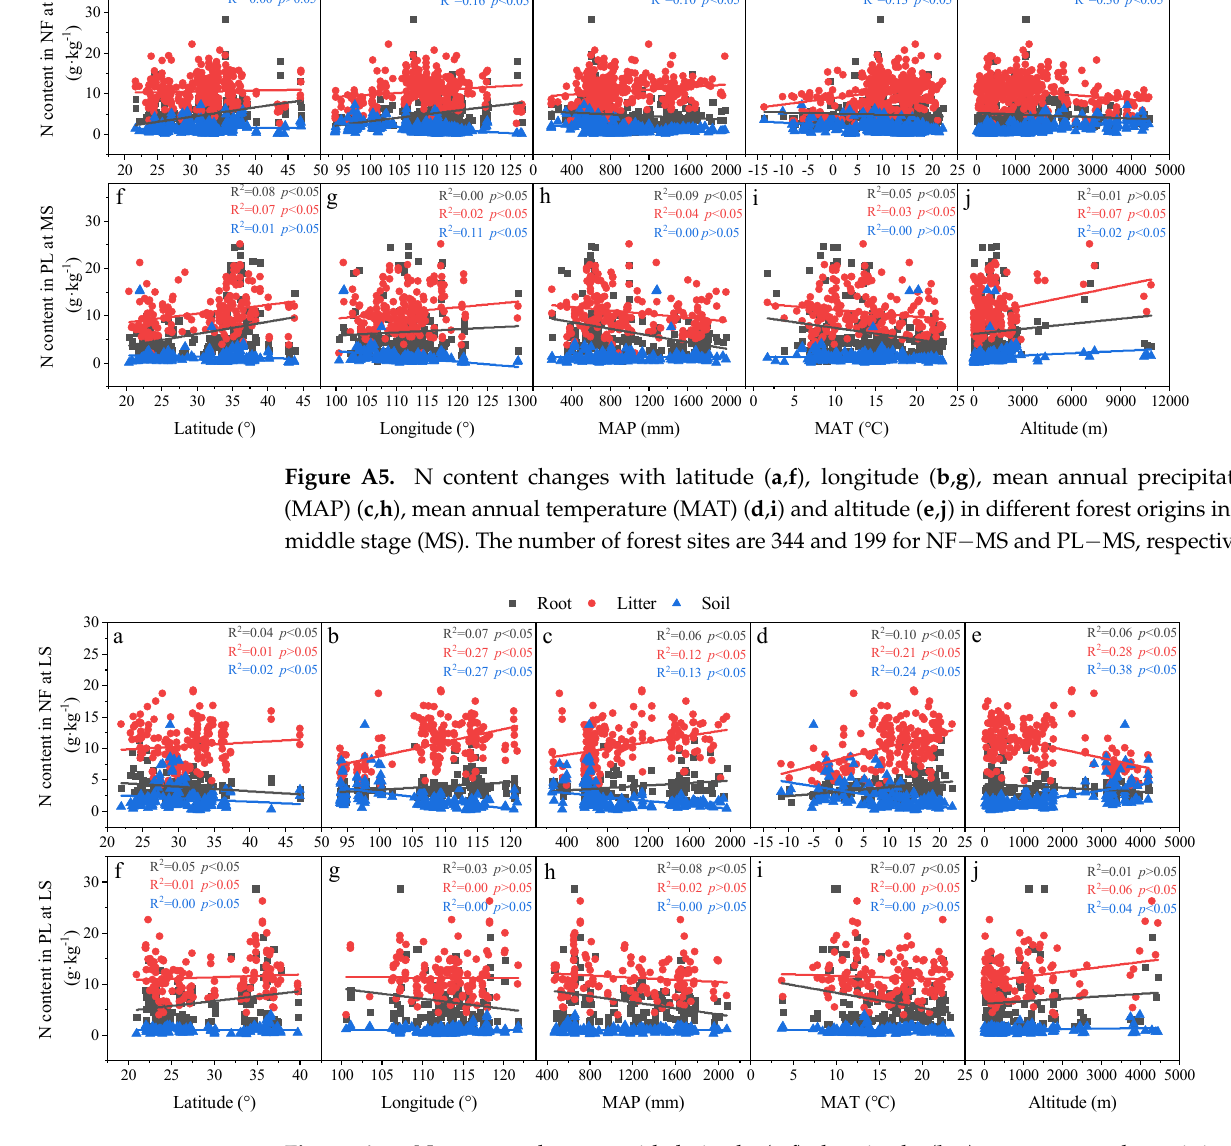
Figure A6. N content changes with latitude ( a , f ), longitude ( b , g ), mean annual precipitation (MAP) ( c , h ), mean annual temperature (MAT) ( d , i ) and altitude ( e , j ) in different forest origins in the late stage (LS). The number of forest sites are 114 and 144 for NF − LS and PL − LS, respectively.